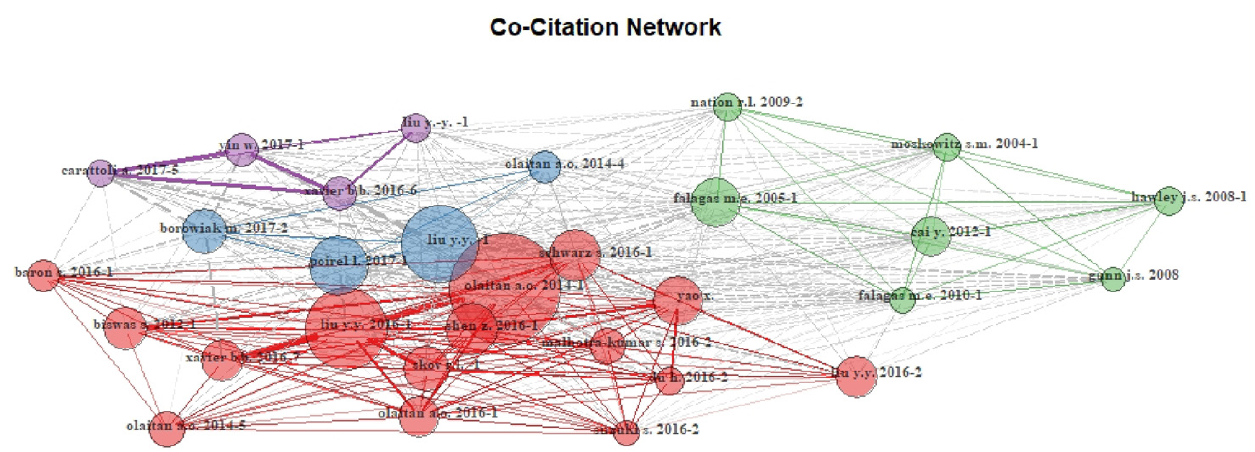
Figure 4. The co-citation network map of references from publications in colistin resistance research. Each node in the network symbolizes a different author’ co-citation. The node’s diameter corresponds to the strength of co-citation. Links represent co-citation pathways between authors. Co-citation network of authors showed four clusters. Links diameter represent the strength of co-citation.